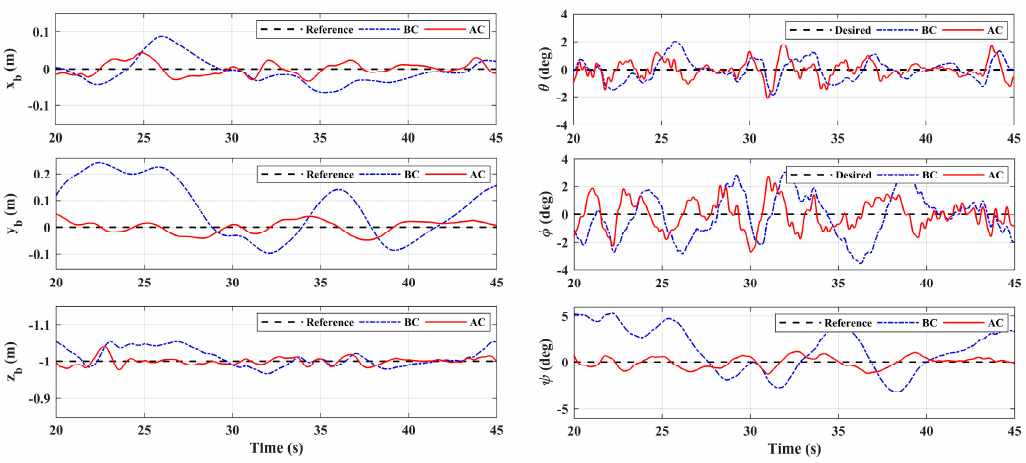
Figure 12. Joint angles in the hovering test.